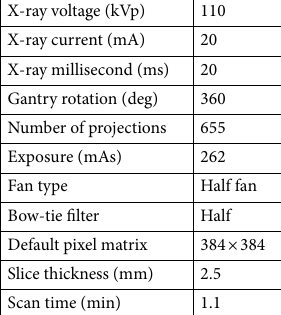
Table 1. Details regarding the CBCT-protocol used for daily, EOD or weekly